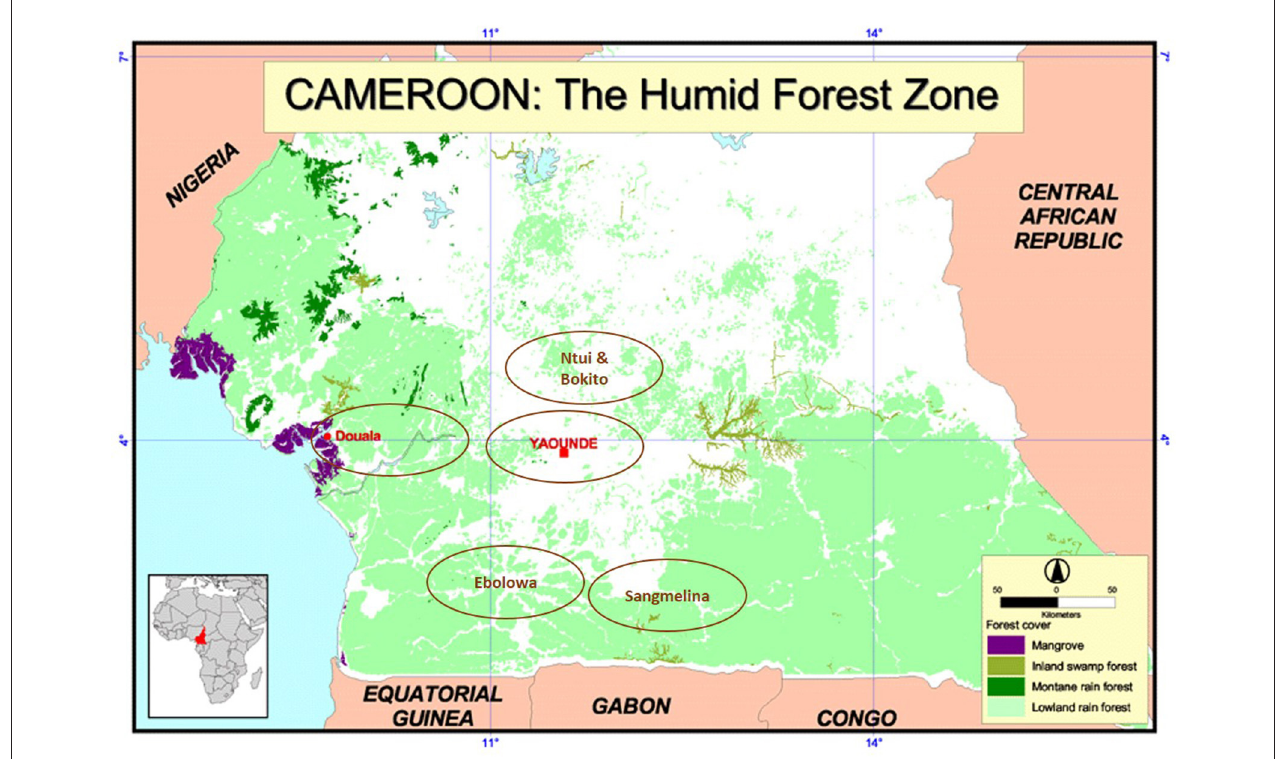
FIGURE 1 | Location of the study